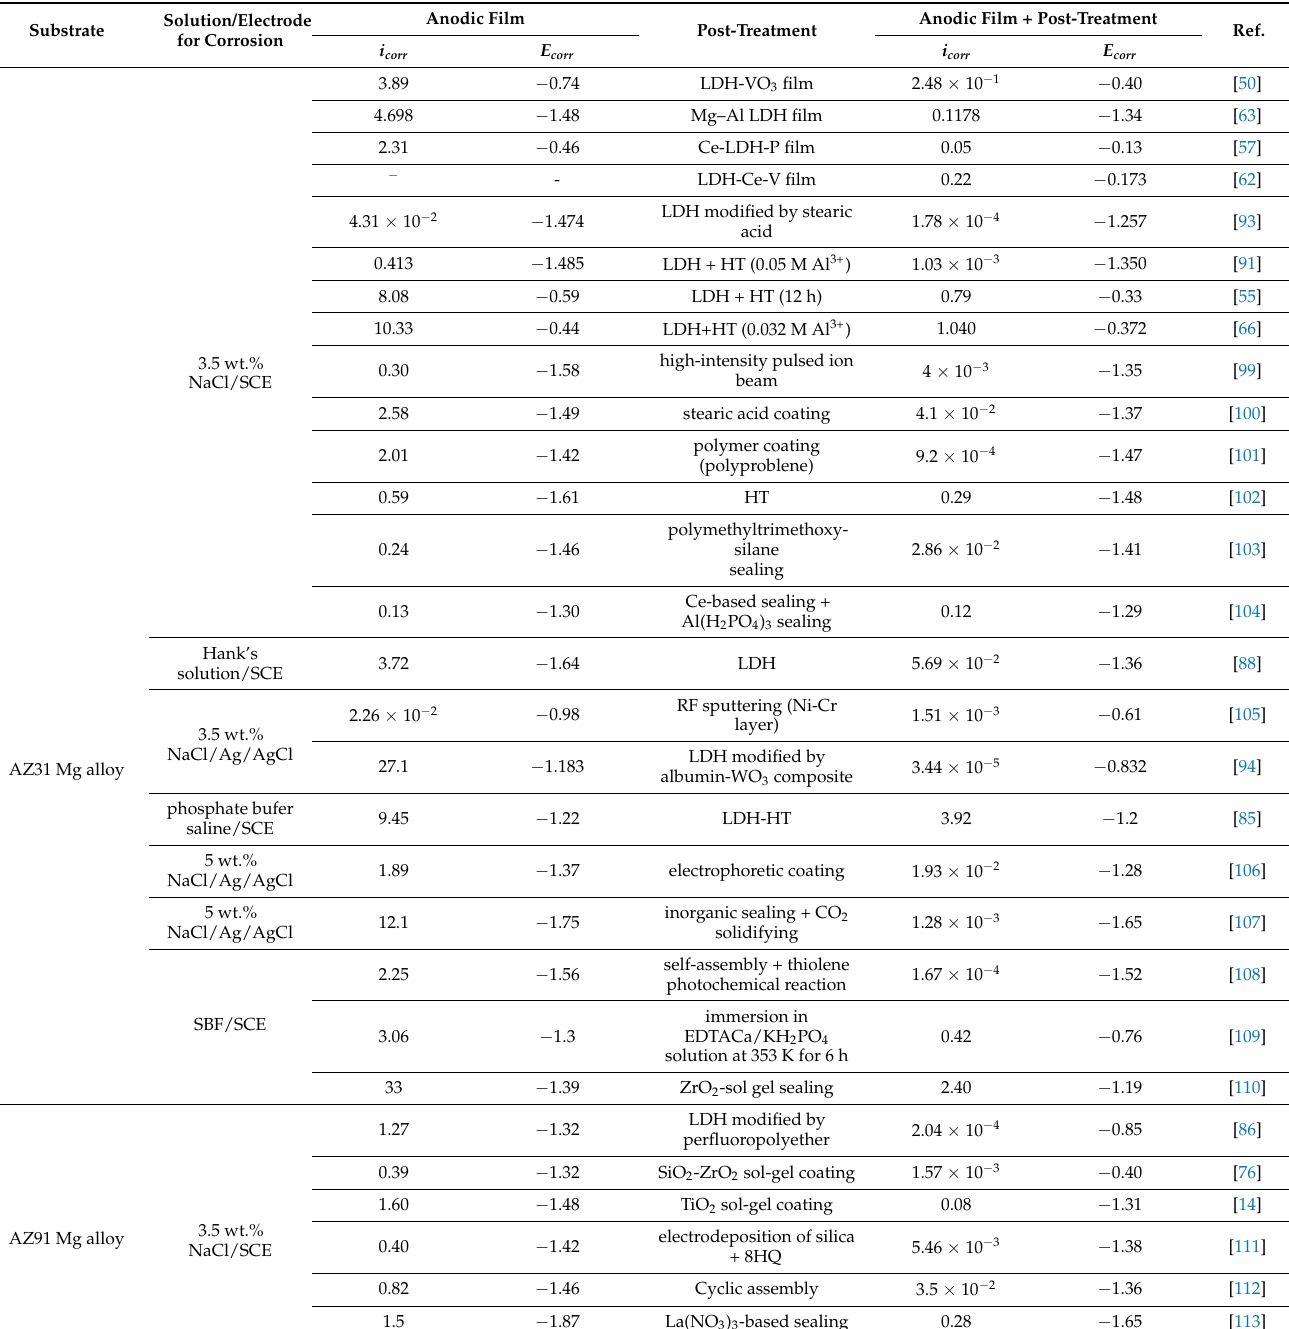
Table 1. Summary of i corr and E corr obtained from the potentiodynamic polarization tests of the anodic films of Mg alloys post-treated by different methods. The units for i corr and E corr are µ A · cm − 2 and V, respectively, in the table.